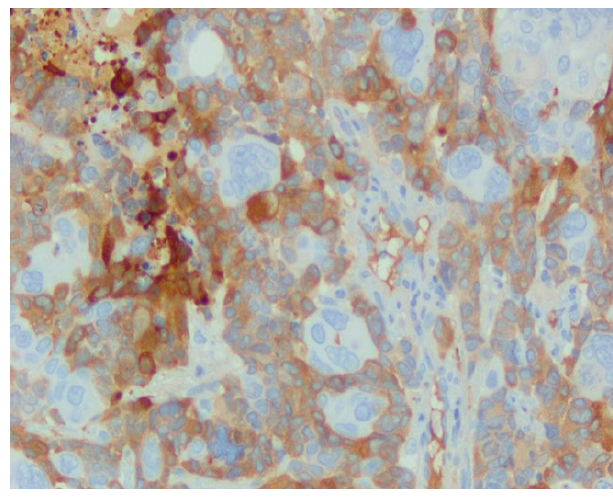
Figure 7. NSE, small cell carcinoma.